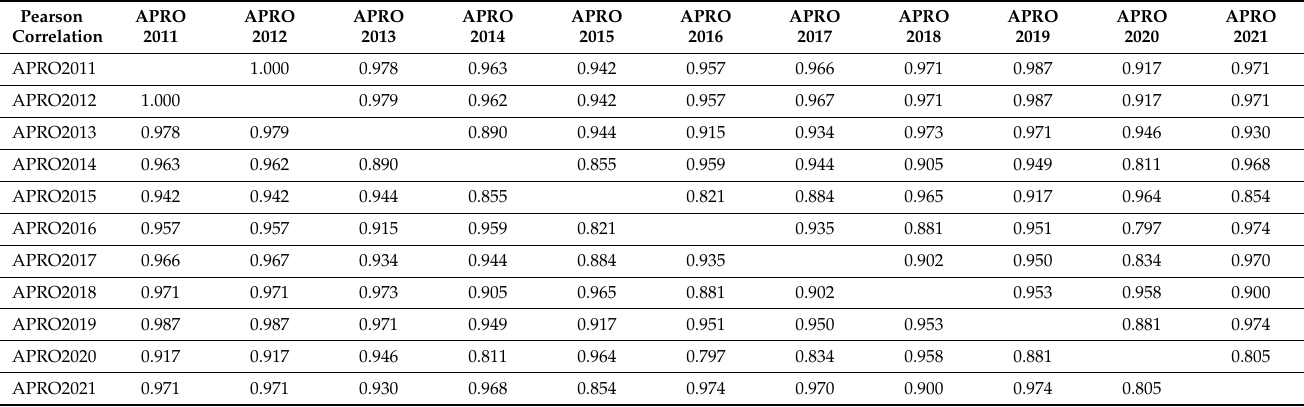
Table A4. Pearson correlation rates in dynamics for crop production in EU standard humidity